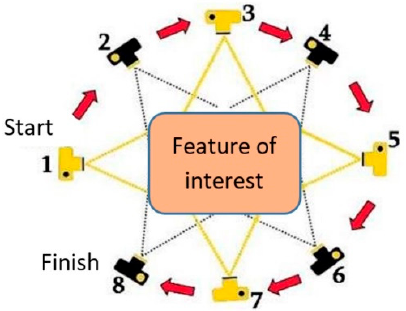
Figure 1. Taking a series of photos in the Structure from Motion method.